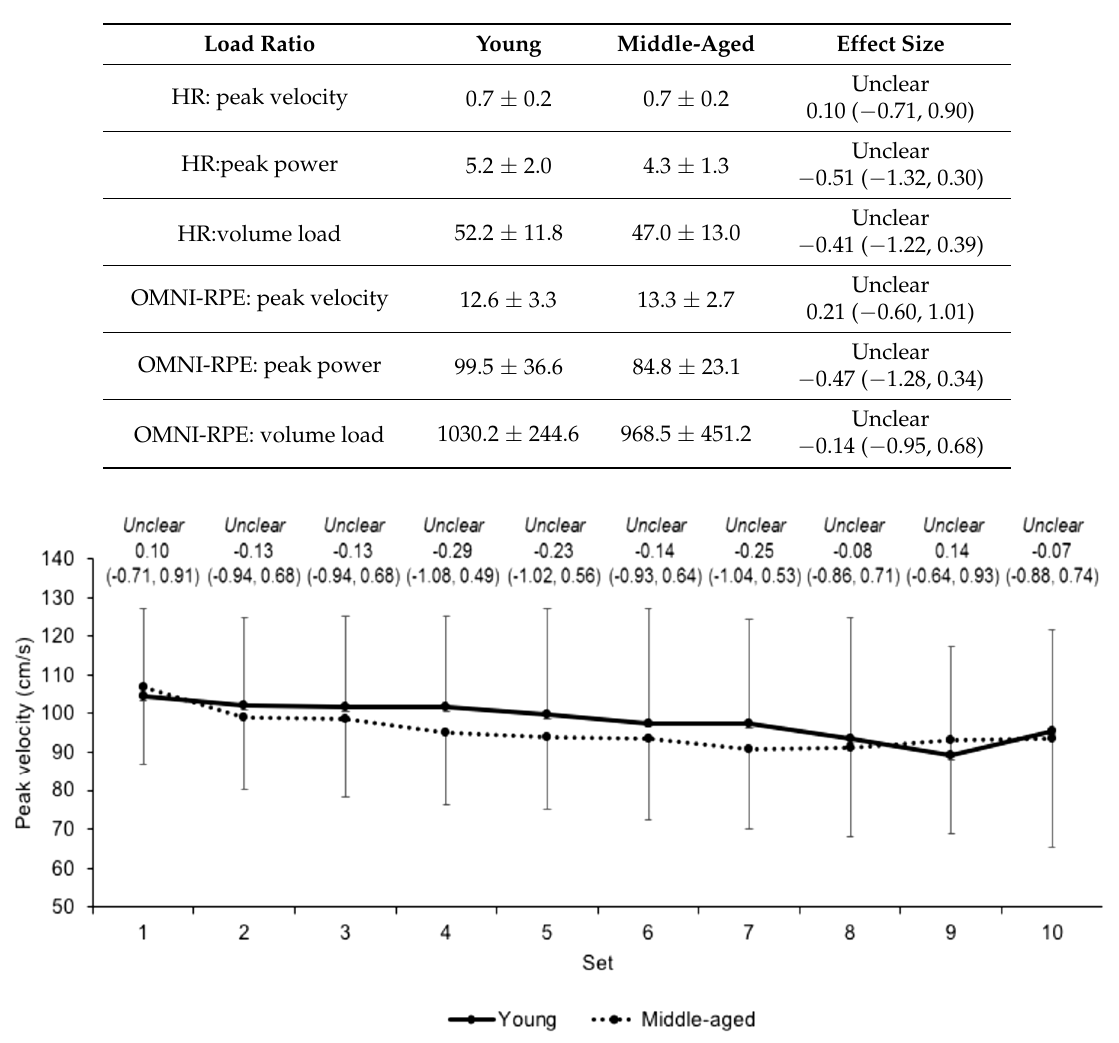
Table 2. The external to internal load ratio during the exercise protocol in the young and middle-aged groups. Qualitative descriptor, effect size, and upper and lower 90% confidence intervals are noted in the effect size column.